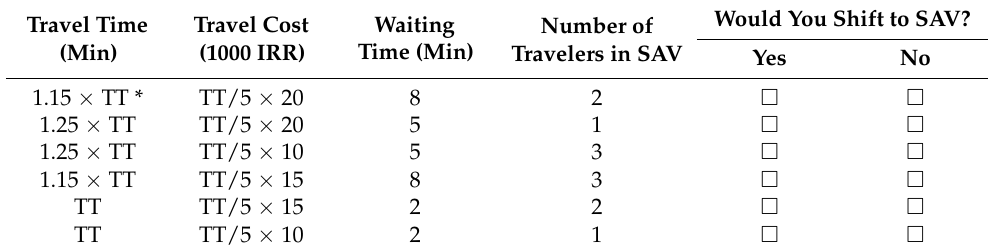
Table 3. An example of conjoint format of the modal shift to SAVs for private car users. Travel Time